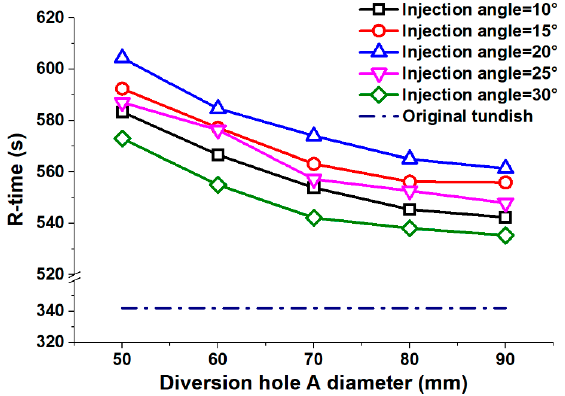
Figure 5. Average residence time distribution.